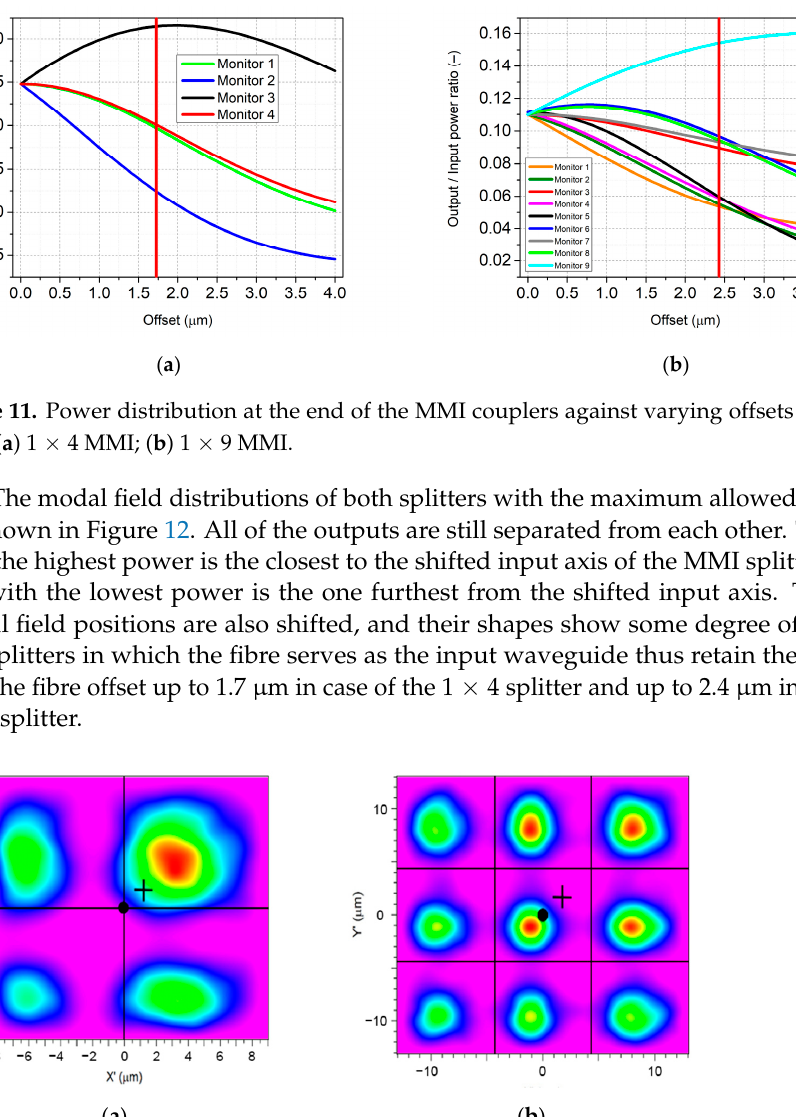
Figure 12. Output modal field distributions at the end of the splitters with off-centred fibre. Central axis of the MMI is denoted by the black dot, central axis of the input fibre is denoted by the black cross: ( a ) 1 × 4 splitter with the offset of 1.7 μ m; ( b ) 1 × 9 splitter with the offset of 2.4 μ m.